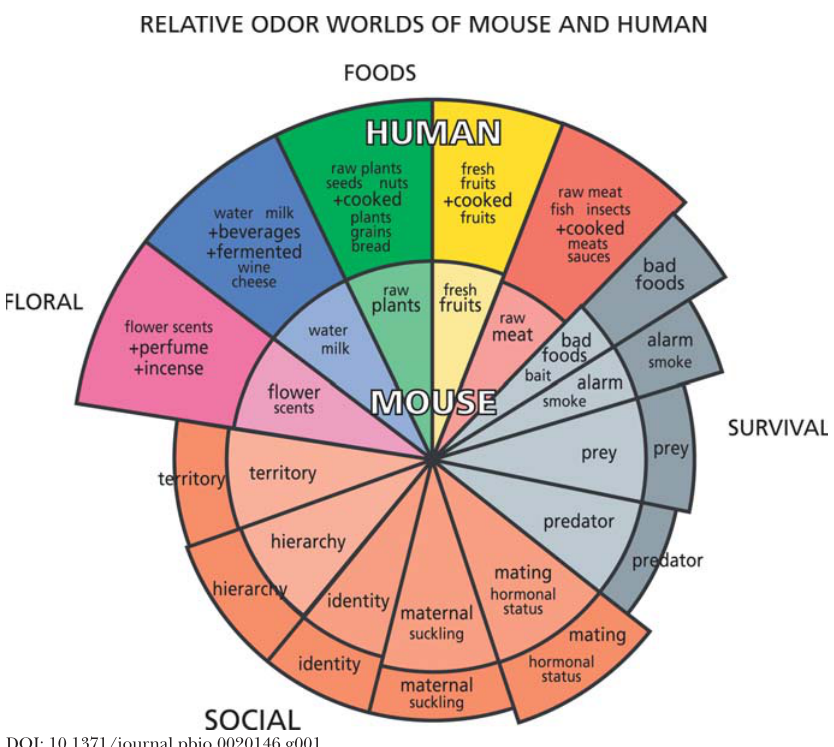
Figure 1. Hypothetical “Odor Wheel” Representing and Comparing the Odor Worlds of Mouse and Human The inner part represents the different categories of odors for the mouse; the relative importance of each category for mouse smell-dependent behavior is indicated by the area of each wedge. The outer part represents the same categories for the human; the importance of each category for human smell-dependent behavior compared with the mouse is indicated by the area of each wedge. Note the greater importance of food odors for the human, refl ecting the factors discussed in the text. Note also the retention of some sensitivity in humans to social odors and other odors prominent in rodents, though in many cases to still undetermined degrees. Based on numerous sources and the hypotheses discussed in the